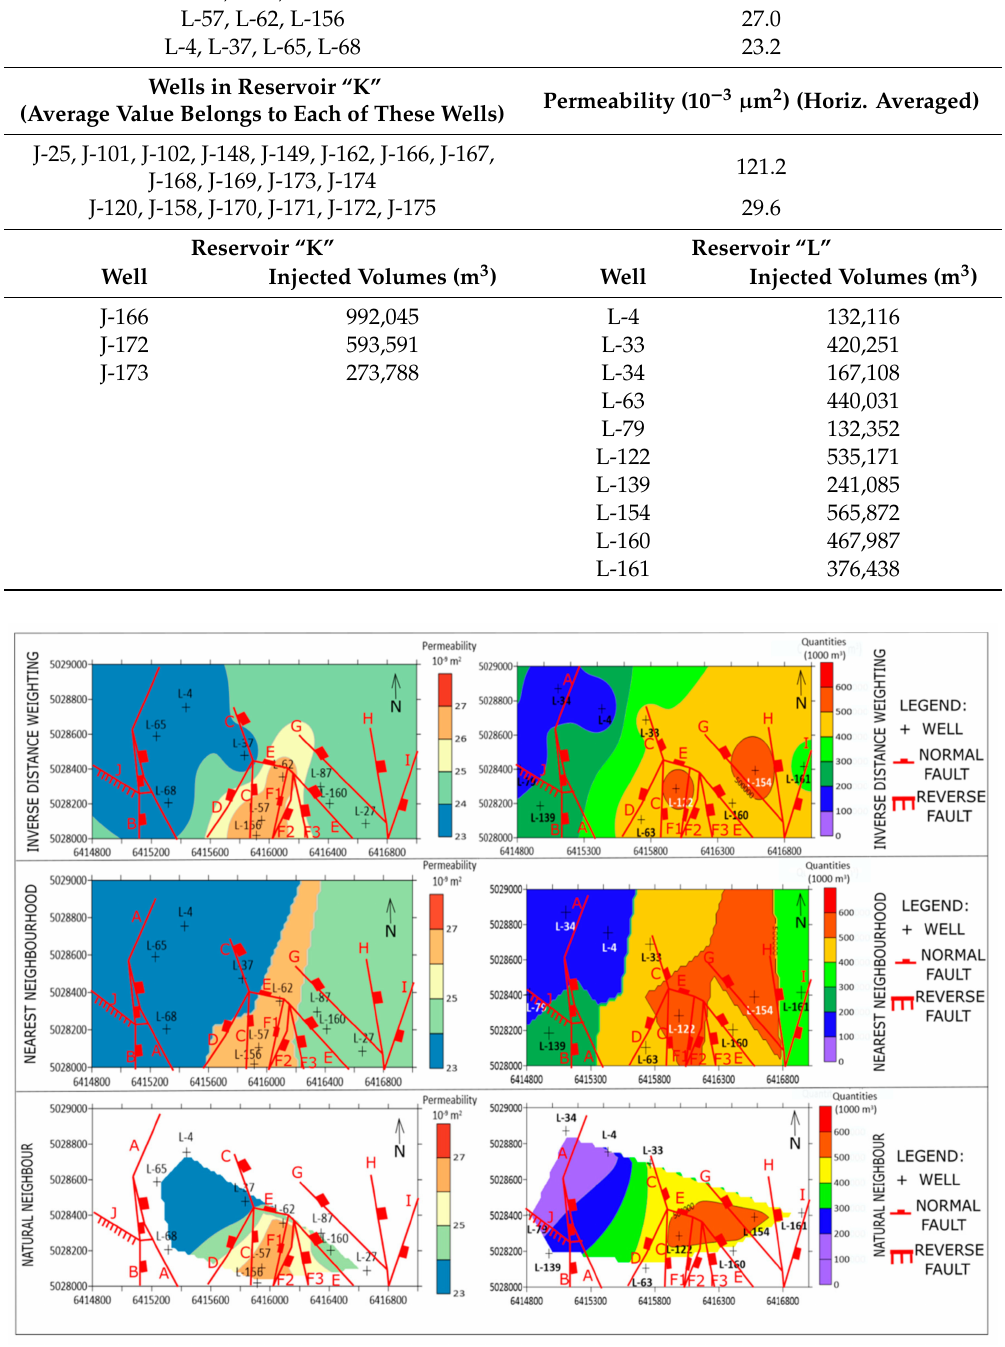
Figure 8. Results of IDW, NN and NaN methods (from top to bottom) of the permeability ( left ) and injected volumes ( right ) in the “L” reservoir. Faults are marked with letters, as are mentioned in the